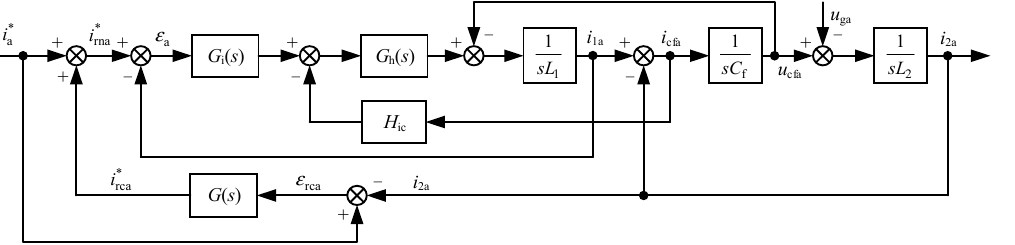
Figure 3. Control block diagram of indirect current control with reference current compensation.